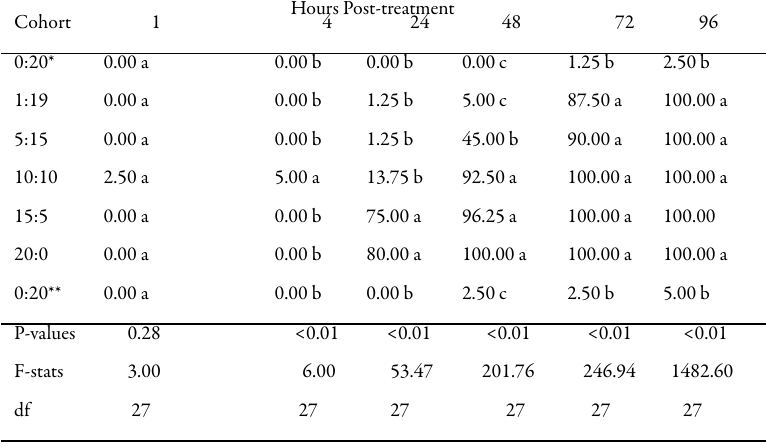
Table 2 . Total mean percent mortality (both donors and recipients combined) of different cohorts of donor:recipient Coptotermes formosanus when donors were exposed to soil treated with Termidor® HE at 0.12% AI through